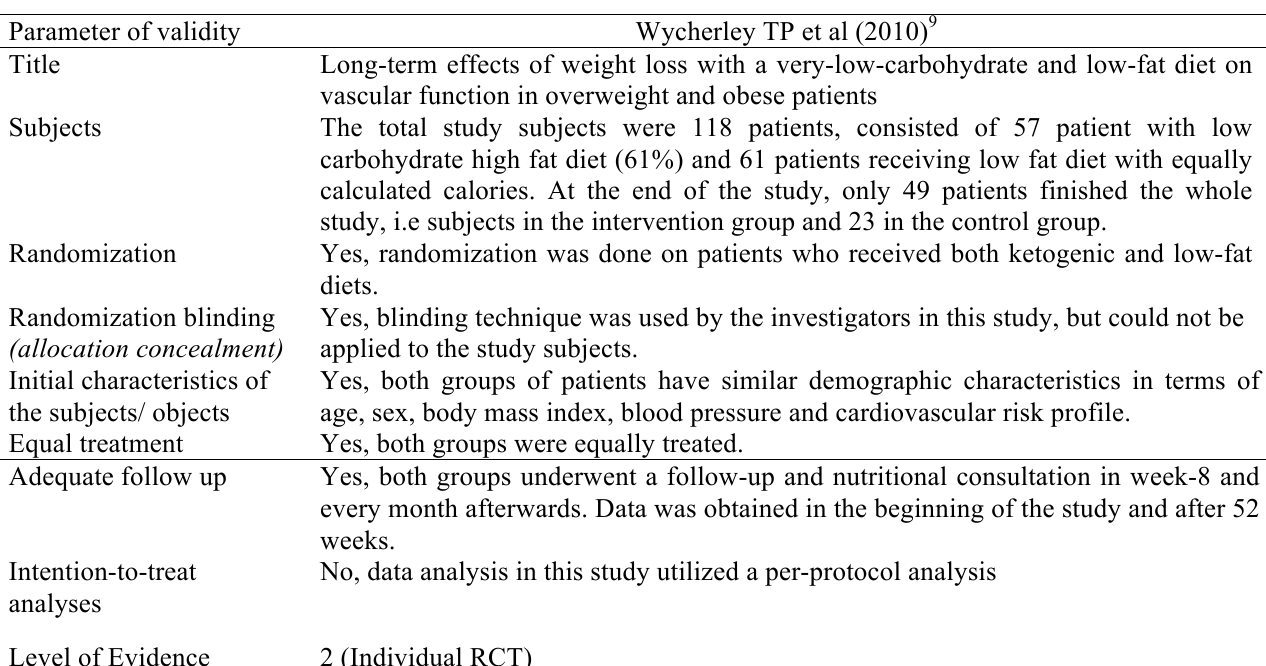
Table 3. Critical appraisal on the validity of study